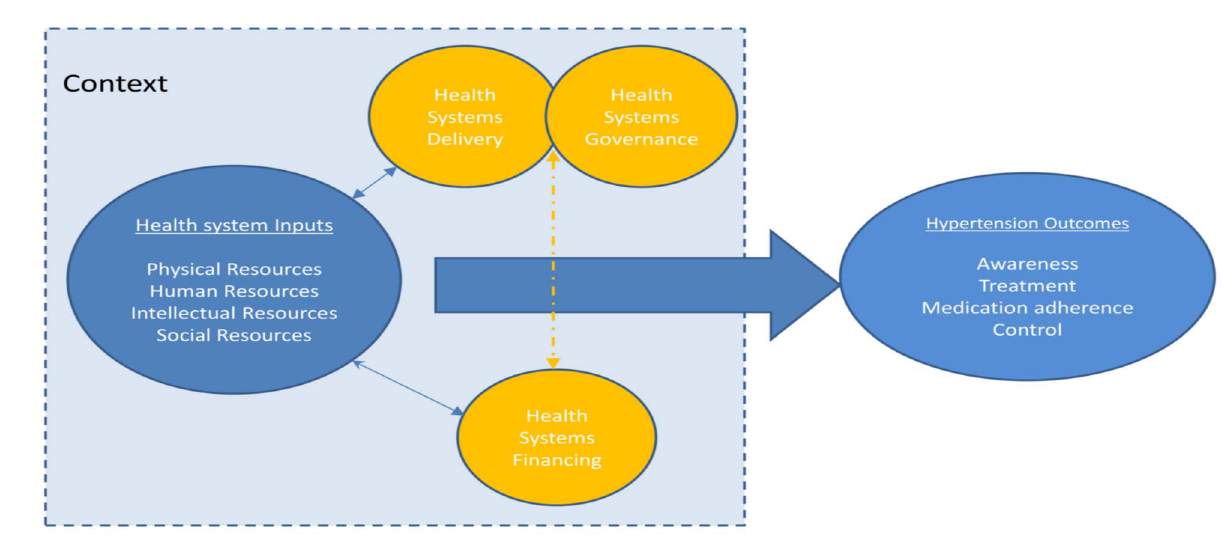
Figure 1. Schematic diagram of health systems conceptual framework.